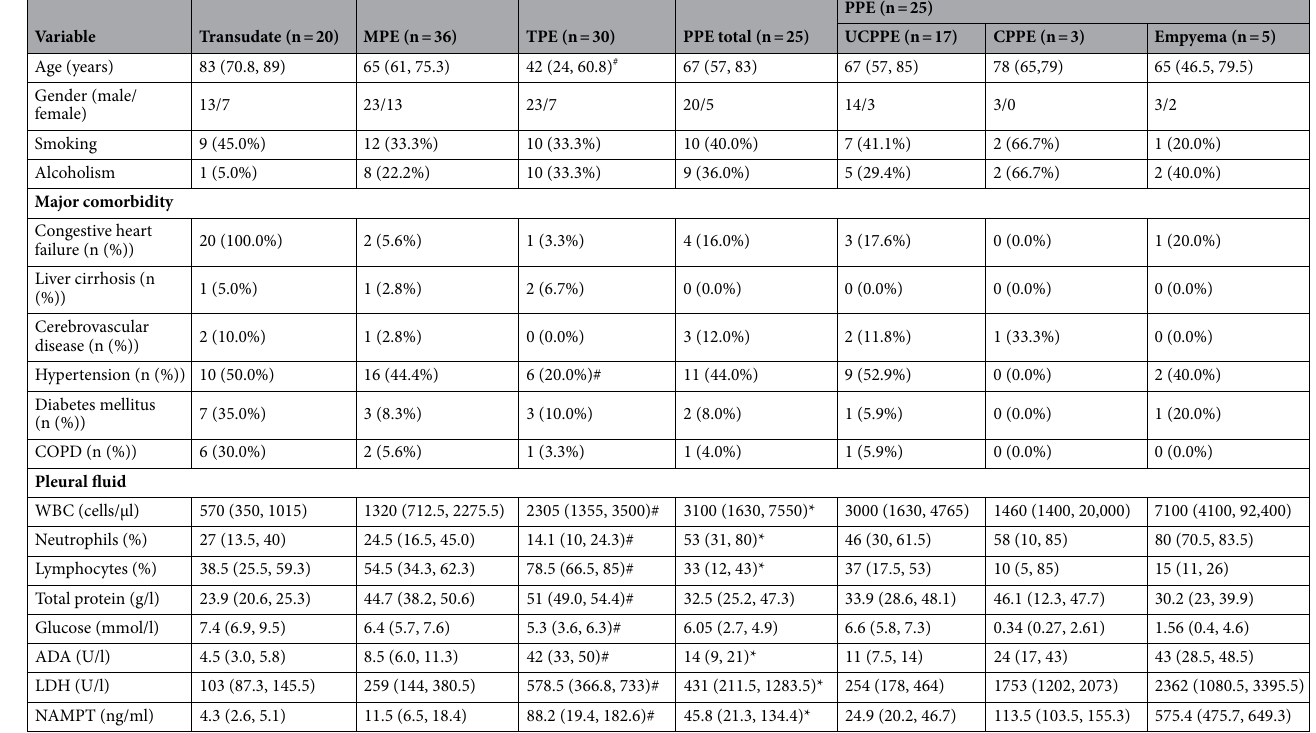
Table 1. Clinical characteristics of the patients in the study. MPE malignant pleural effusion, TPE tuberculous pleural effusion, PPE parapneumonic effusion, UPPE uncomplicated parapneumonic effusion, CPPE complicated parapneumonic effusion, COPD chronic obstructive pulmonary disease, WBC White blood cell count, ADA adenosine deaminase, LDH lactate dehydrogenase, NAMPT , nicotinamide phosphoribosyltransferase; Data of CPPEs are presented as median (minimum, maximum); Other data are presented as median (interquartile ranges); # p < 0.05 tuberculous vs. malignant pleural effusion; *p < 0.05 parapneumonic vs. malignant pleural